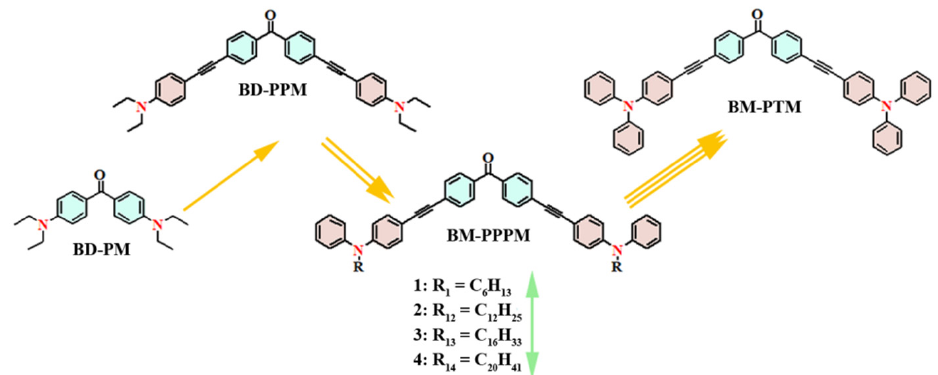
Figure 1. The structural formulas of BD-PM (UV photoinitiator), BD-PPM [28], BM-PPPM and BM-PTM [29].